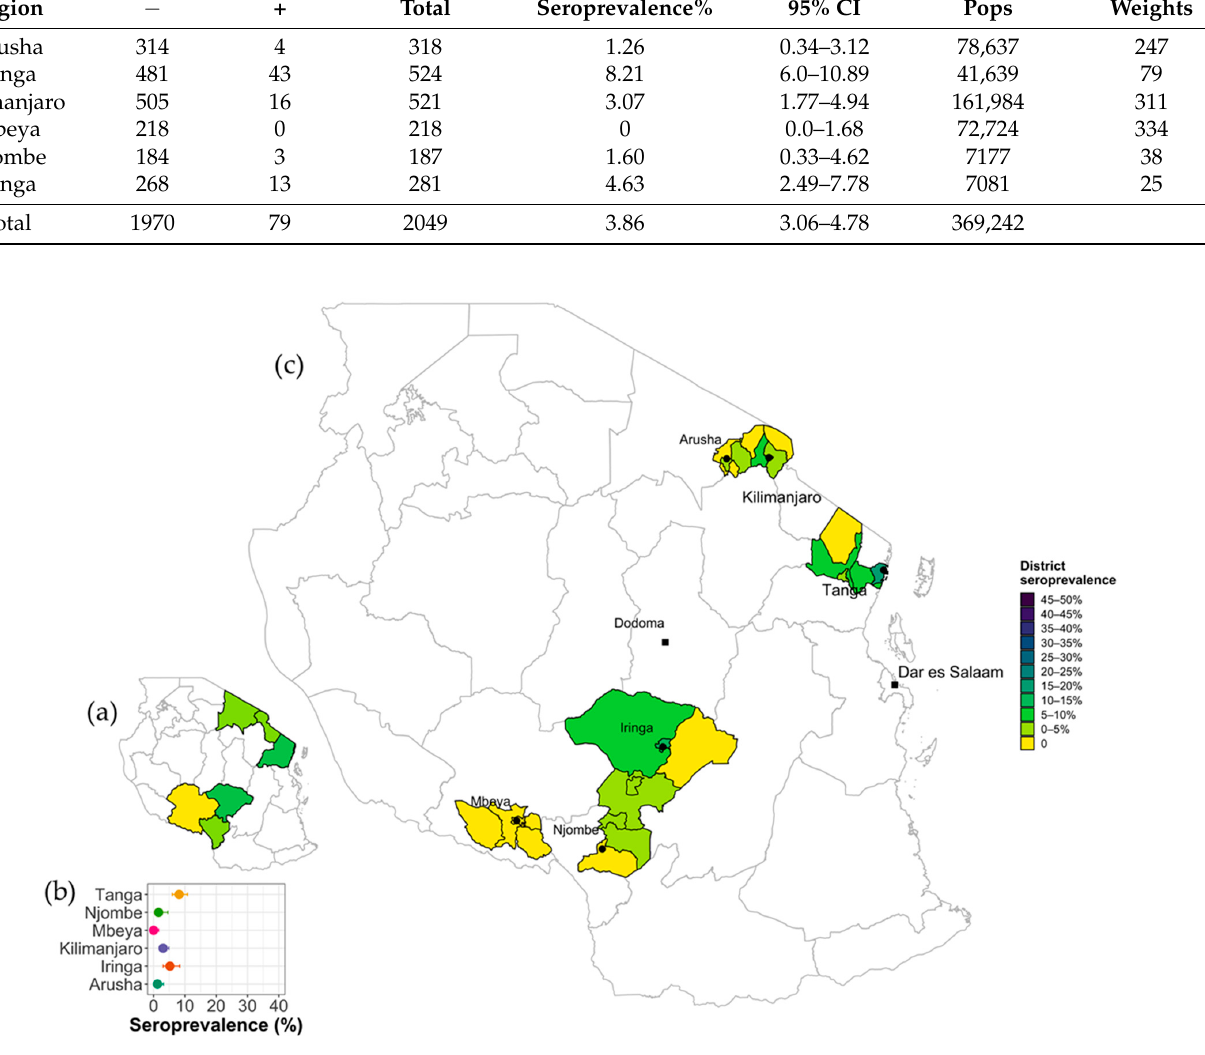
Figure 3. Q fever seroprevalence spatial variation across sampled Regions and Districts in Tanzania. ( a ) Inset map showing regional seroprevalence across six study Regions. Colored areas were sampled, and white areas were not sampled ( b ). Forest plot with Q fever seroprevalence (%) point estimate and 95% CI for each Region. ( c ) Choropleth map showing the seroprevalence at District